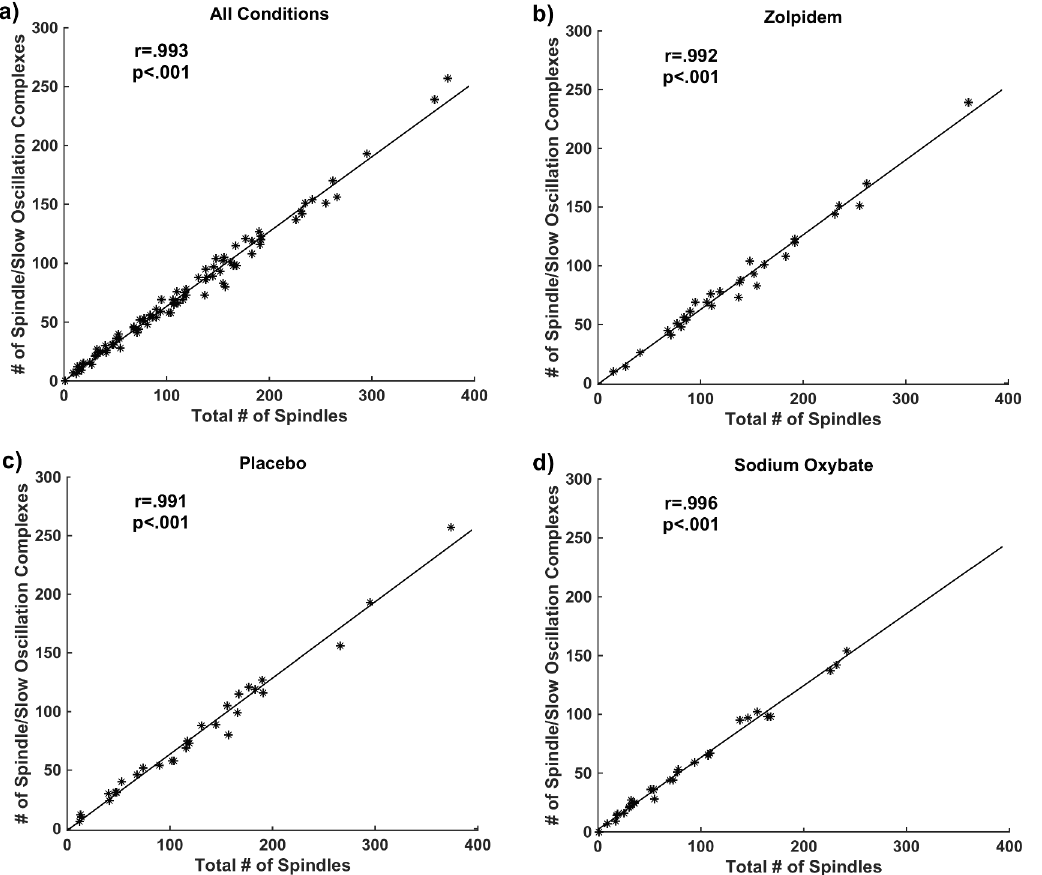
Fig 2. Spindles and Spindle/SO Complexes: During Stage 2 sleep, the number of spindle/SO complexes and the number of spindles were highly correlated in all subjects suggesting a functional relationship. (a) : All conditions, (b): zolpidem, (c): placebo (d): sodium